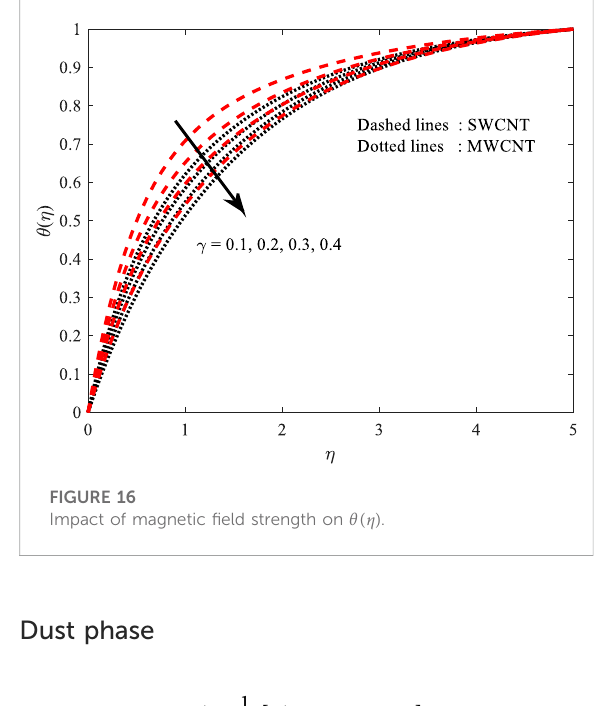
FIGURE 15 Impact of the melting parameter on θ p ( η ) .